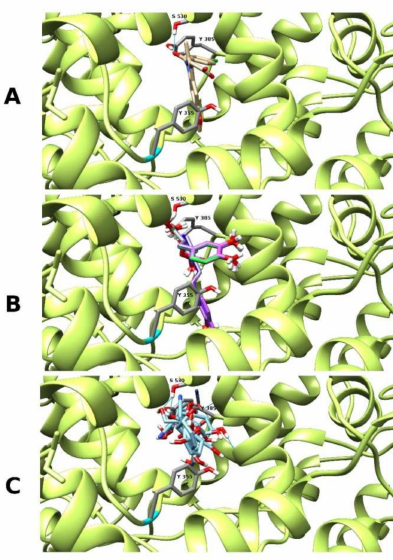
Figure 3. The molecular docking of menisdaurin ( C ) and salvianolic acid H ( B ) with comparison to reference compound indomethacin ( A ), according to its crystal